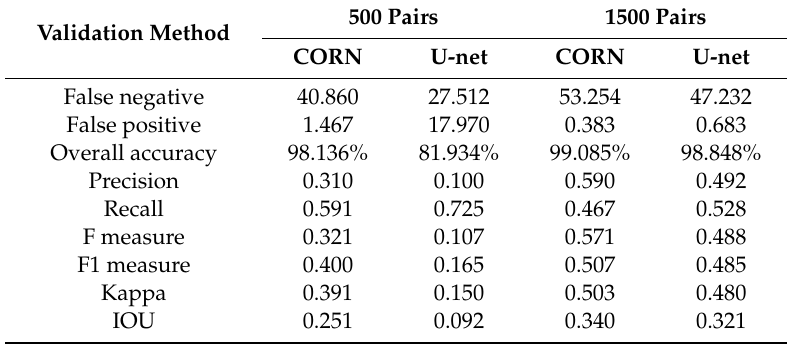
Table 9. Accuracies of the models in the di ff erent number of training data at the Bangkok site.